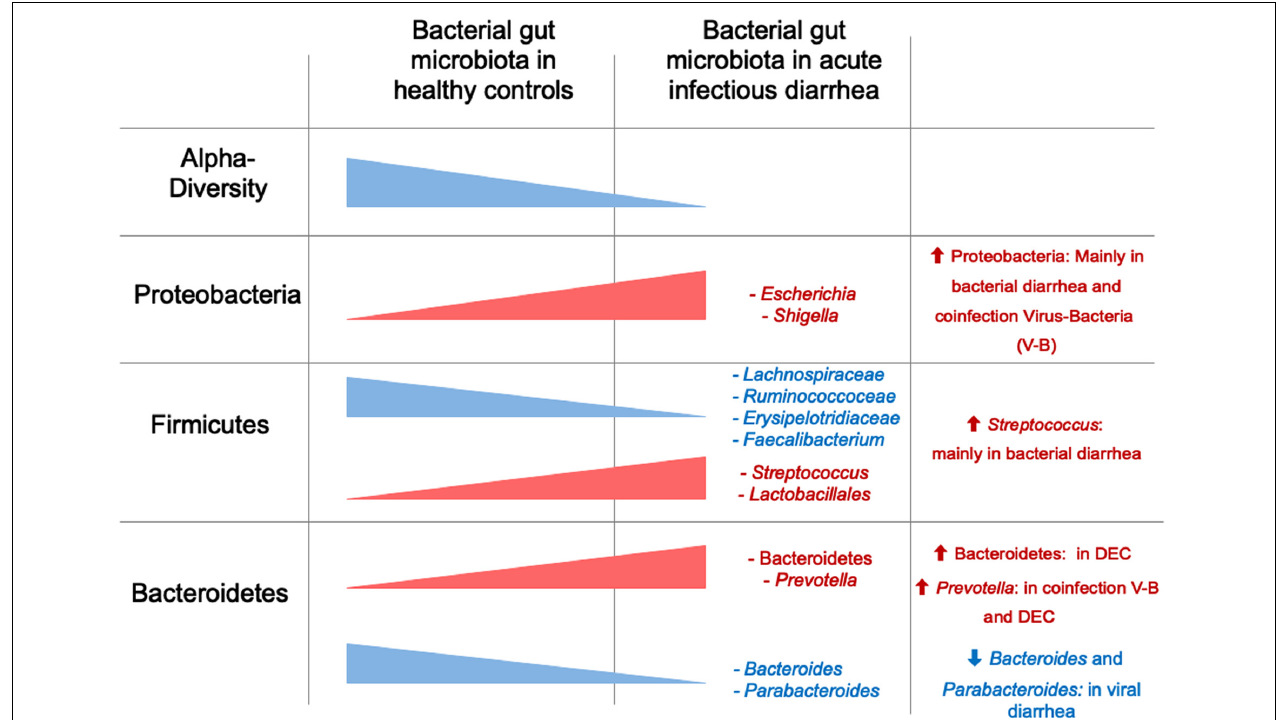
FIGURE 1 | α -diversity and relative abundance of main taxa in children with acute diarrhea compared to healthy controls. Red represents higher diversity or abundance in children with diarrhea, and blue represents higher values in healthy